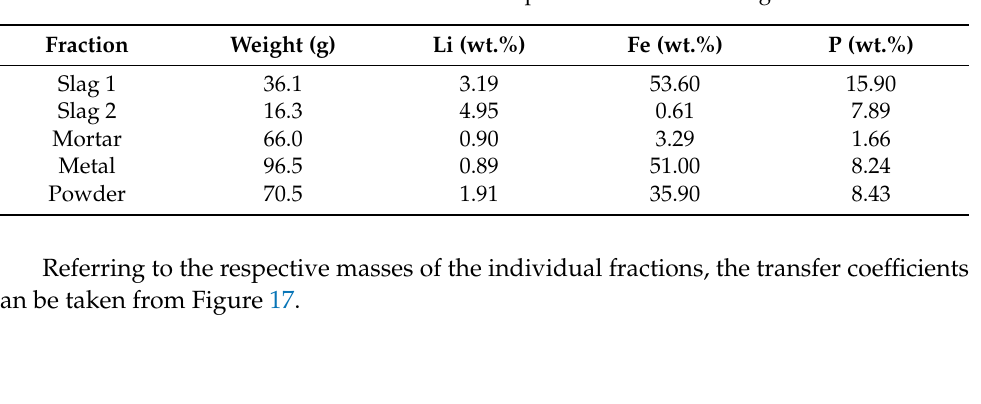
Table 7. Results of the individual fractions after the experiment LFP-C in Design